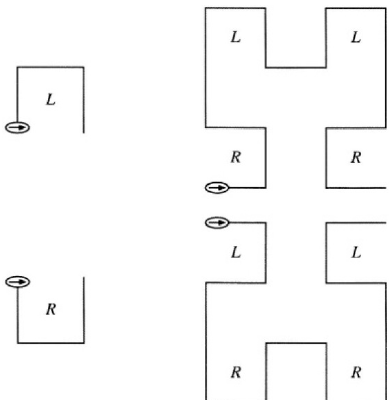
Figure 7. Geometric interpretation of the encoding of the curves and using the symbols L and R ( left ). When starting with axiom R in place of L, we obtain mirror images of the corresponding stages of the Hilbert curve ( right